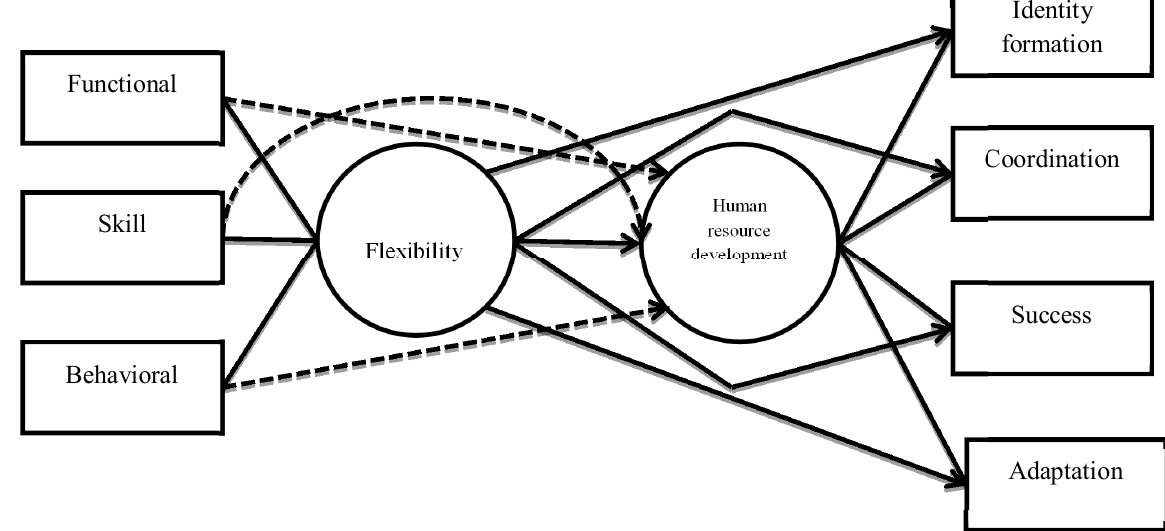
Fig. 1. The proposed study